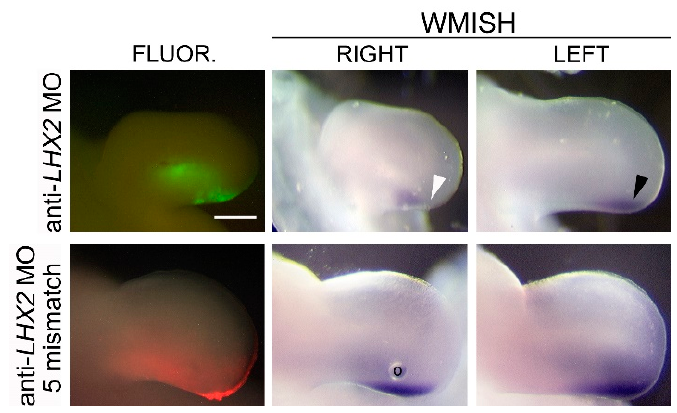
Figure 7. LHX2 knockdown at the ZPA decreases SHH expression. Twenty-four hours after electroporation of anti- LHX2 MO at the ZPA, there is reduced SHH expression and retarded limb outgrowth when compared to the contralateral limb (LEFT) and to the negative control (anti- LHX2 MO five-base mismatch). Reduced SHH expression and retarded limb outgrowth were observed in nine out of 10 embryos from two independent experiments. Please note the oil bubble “o” in the bottom row (middle panel). The images of the left contralateral control limbs have been reversed for comparison. Scalebar = 0.25 inches.